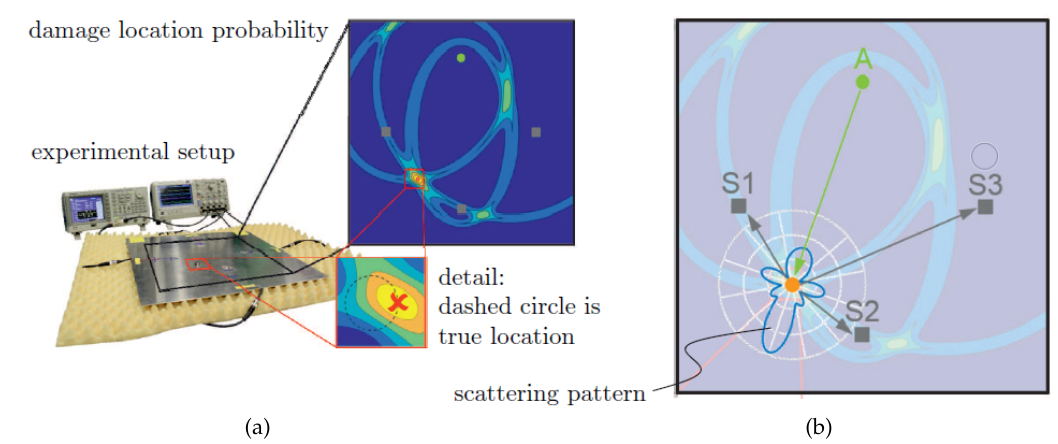
Figure 8. ( a ) UGW damage (magnet) localization in thin aluminum plate by ToF triangulation with one actuator (A) and three sensors (S). ( b ) Identification of damage by its characteristic frequency dependent scattering pattern evaluated at the three sensor position angles